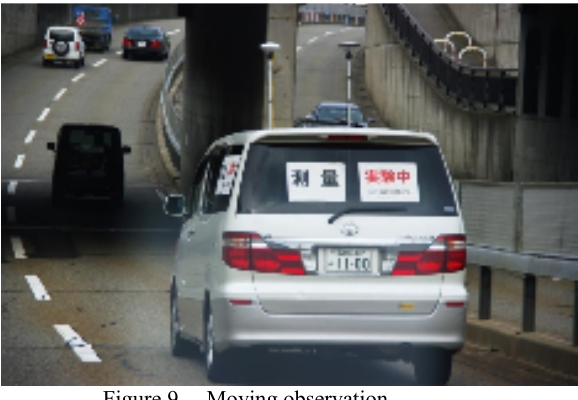
Figure 9. Moving observation